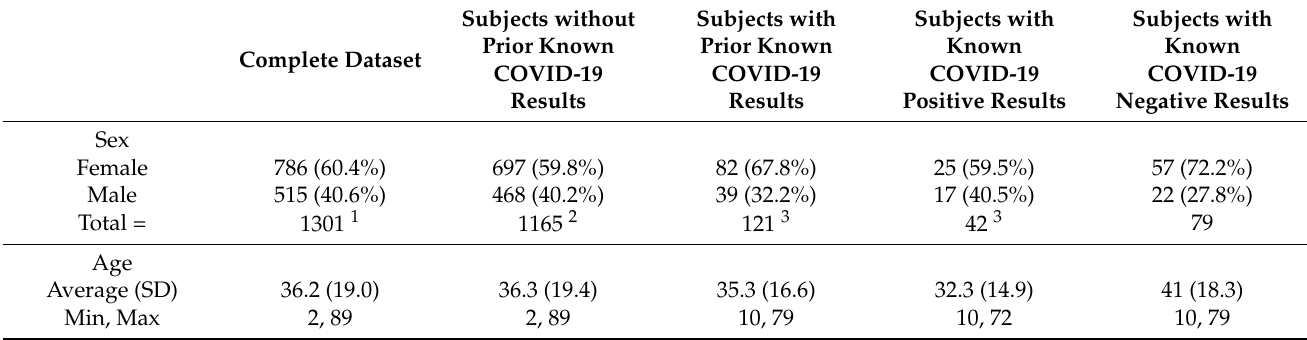
Table 1. Sex and age of the subjects in the dataset.